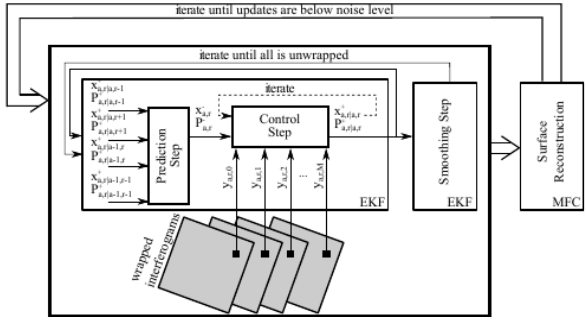
Figure 1 : Box diagram for the proposed method. The figure displays the EKF variables: x (EKF state), P (Error Covariance), y (interferometric observations), a (azimuth), r (range).